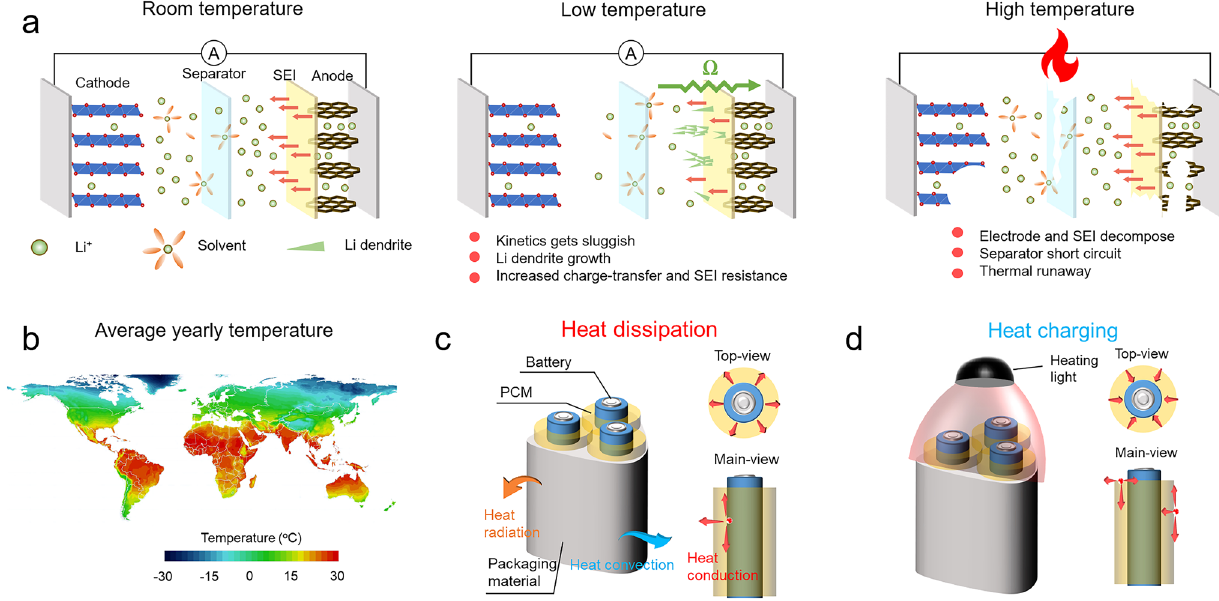
Fig. 1 a Mechanisms of battery performance degradation at low temperature and high temperature from a material perspective. b Geographic distribution of world average annual temperature [12]. c Working principle of passive battery thermal management at high temperature using our PCM thermal regulator. d Working principle of heating of battery in a cold environment through light-to-heat